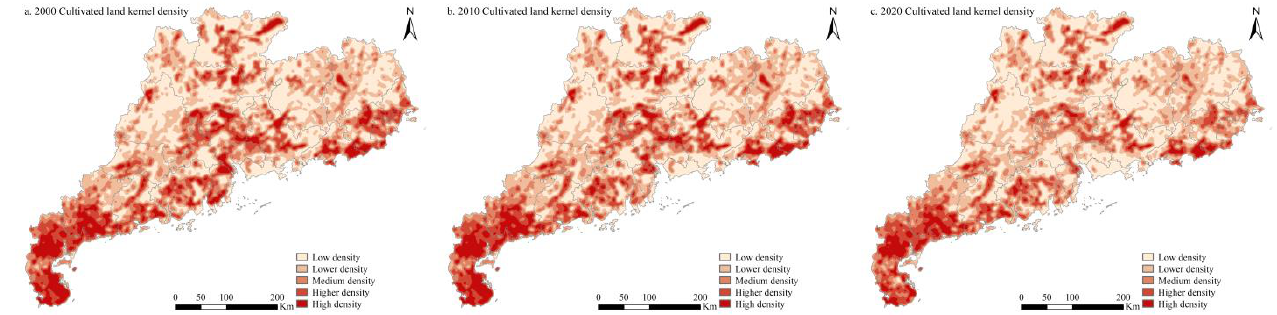
Table 3. The area ratio of each cultivated land kernel density grade zone in Guangdong Province in